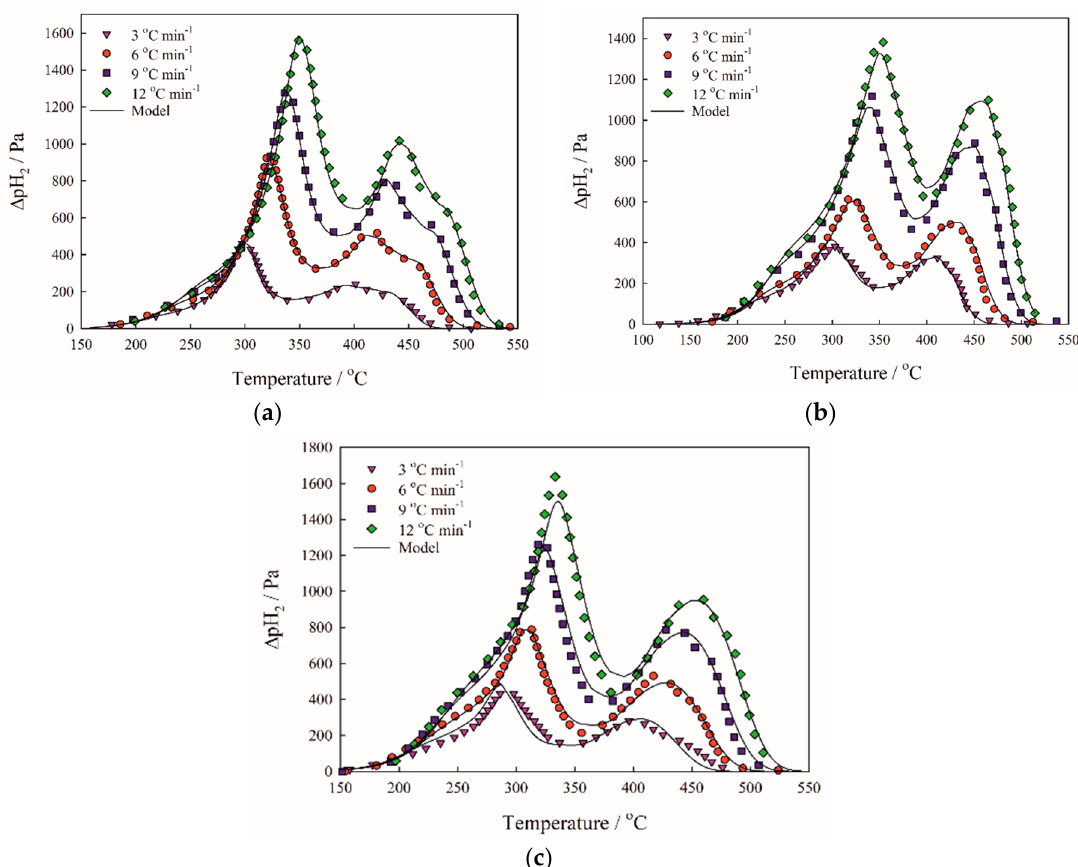
Figure 5. TPR curves of the investigated birnessite samples. ( a )— δ -MnO 2 ; ( b )— δ -MnO 2 -3cycle; ( c )— δ -MnO 2 -N 2 H 4 .